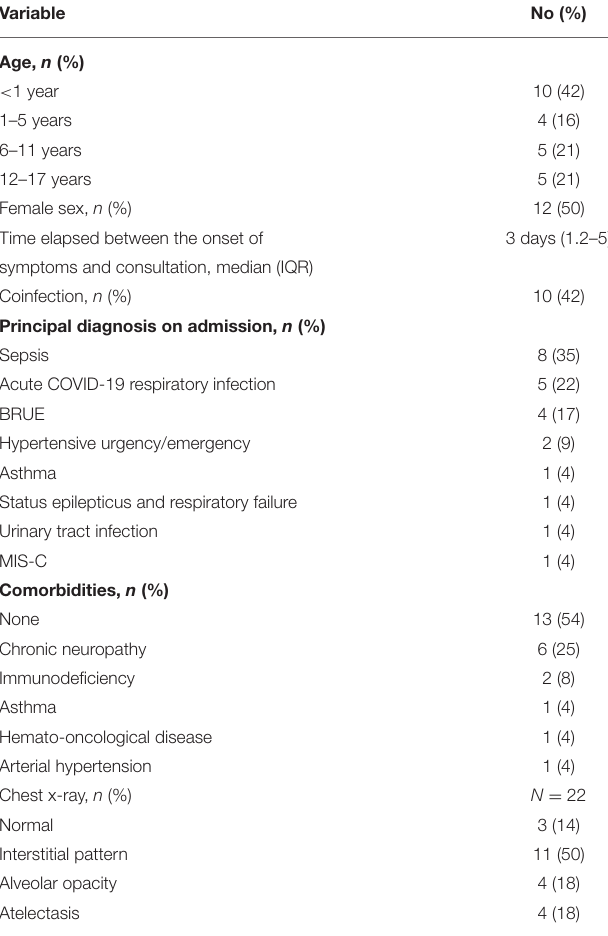
TABLE 4 | Characteristics of patients admitted to the pediatric intensive care unit.